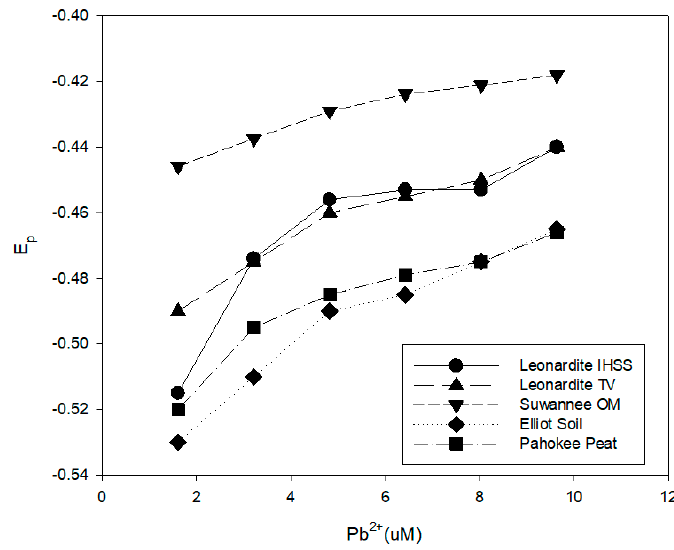
Figure 8. Comparison of DPP results for Pb 2 + at pH 8 in the presense of 100 mg / L of the various humic acids.